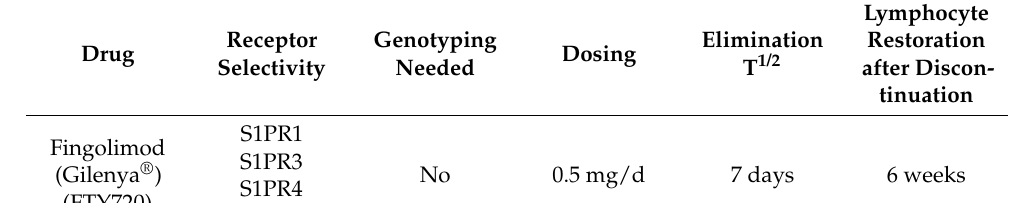
Lymphocyte Restoration Elimination Dosing after Discon- T 1/2